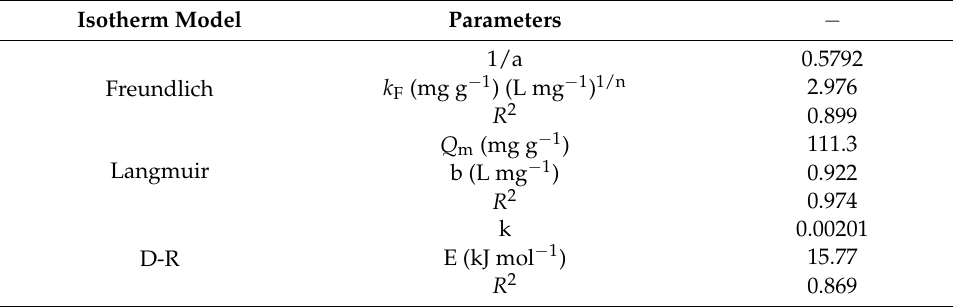
Figure 4. Static adsorption thermodynamics: ( a ) The fitting curve of Freundlich model; ( b ) The fitting curve of Langmuir model; ( c ) The fitting curve of D− R model. Table 1. Adsorption isotherm parameter for Cu 2+ adsorption on sandwich adsorptive membrane.